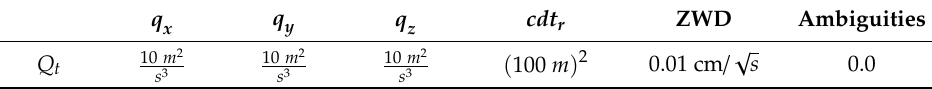
Table 2. Initial guess Q t for kinematic PPP: ZWD is zenith wet delay of troposphere. q q y q z cdt r x